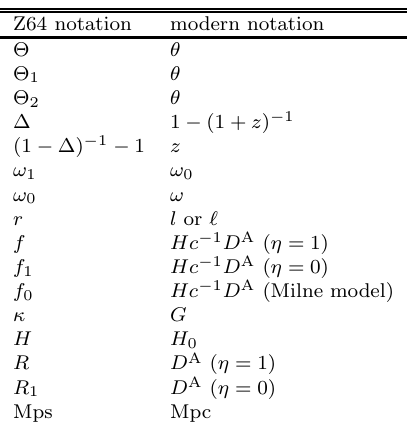
TABLE 1 Note that t , t 0 , c , ρ are the same in the Z64 and modern notations. Z64 distinguishes between Θ and Θ 1 for the cases η = 1 and η = 0 , respectively, though in both cases the quantity is the observed angular size. Similarly, Θ 2 is the observed angular size in the case of strong gravitational lensing. Except in the case of f 0 , quantities dependent on the cosmological model assume the Einstein–de Sitter model.